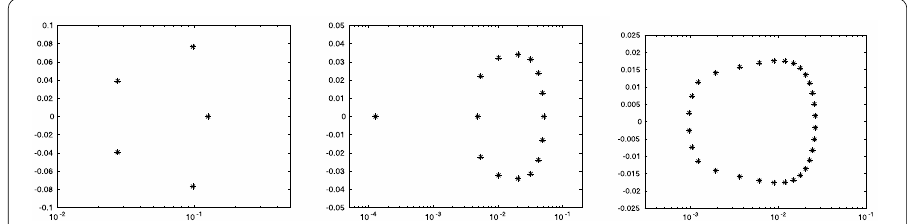
Figure 15 Eigenvalues of U n in the case of a two-interval weight function for n = 5,15,30 (from left to right)